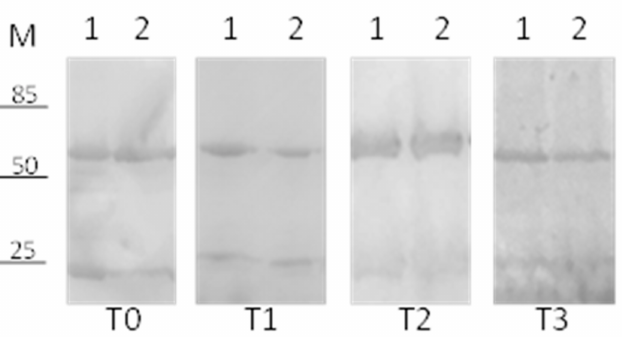
Figure 5. SDS-PAGE analysis to assess the effect of hyaluronic acid. (M) Marker, 1 NP10 (0.25% HA) stored at 36 ◦ C, 2 NP9 (0.125% HA) stored at 36 ◦ C. T0 (freshly prepared); (T1 (40 days); T2 (60 days); T3 (90